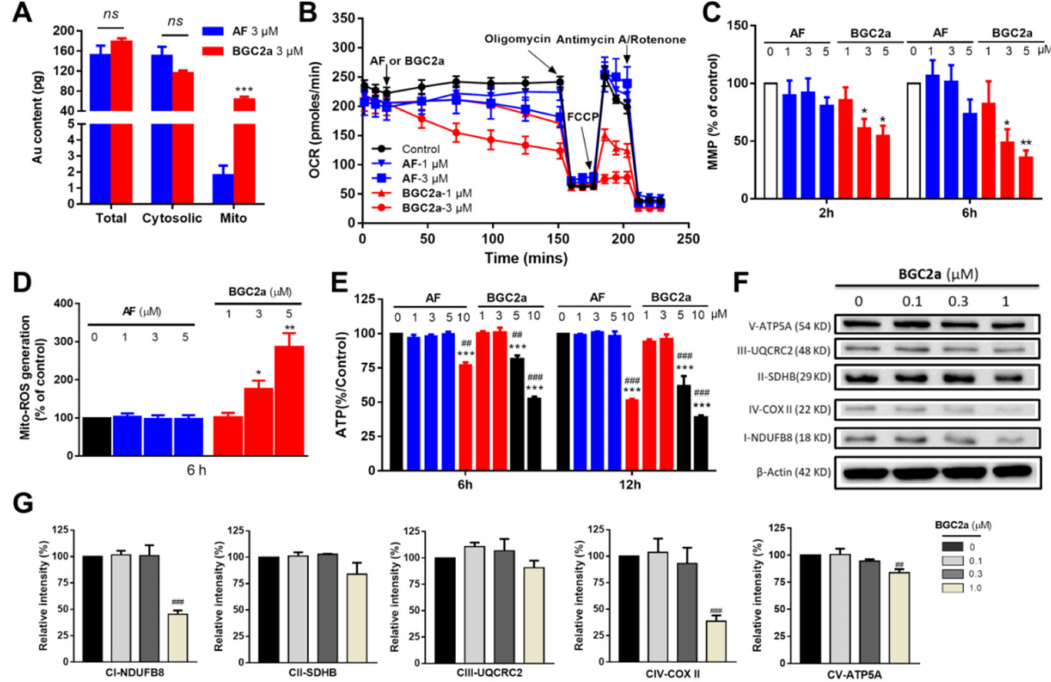
Figure 3. BGC2a accumulated in mitochondria and impacted mitochondrial functions of A549 cells. ( A ) The intracellular gold (Au) contents were detected after 2 h treatment with AF and BGC2a at 3 µ M. Total intracellular and mitochondrial gold contents were measured by ICP-MS. (***) p < 0.001 vs. the AF group; Note: Mito stands for mitochondria. ns stands for no significant difference. ( B ) The effects on OCR by BGC2a and AF. Oxygen consumption was recorded by the Seahorse Bioscience Extracellular Flux Analyzer under basal conditions and upon oligomycin (1 µ M), FCCP (1 µ M), and Antimycin A/Rotenone (0.5 µ M) at time courses. ( C ) The effect on MMP after 2 or 6 h treatment of AF and BGC2a. Rhodamine-123 (1 µ M, 20 min) was used to stain the cells, and flow cytometry was used to detect the MMP. (*) p < 0.05, (**) p < 0.01 vs. the AF group. ( D ) Mitochondrial ROS production after 6 h treatment. MitoSOX™ Red (5 µ M, 20 min) and flow cytometry were applied to test the ROS in mitochondria. (*) p < 0.05, (**) p < 0.01 vs. the AF group. ( E ) The ATP production after 6 h and 12 h treatment of BGC2a. (***) p < 0.001 vs. the AF group; ( ## ) p < 0.01, and ( ### ) p < 0.001 vs. the control group (one-way ANOVA). ( F ) The Western blot results of the electron transport chain complexes I-V (CI to CV) by measuring their core subunit protein levels and ( G ) their quantification after 24 h treatment of BGC2a. ( ## ) p < 0.01, and ( ### ) p < 0.001 vs. the control group. The resulting protein bands were quantified by using ImageJ